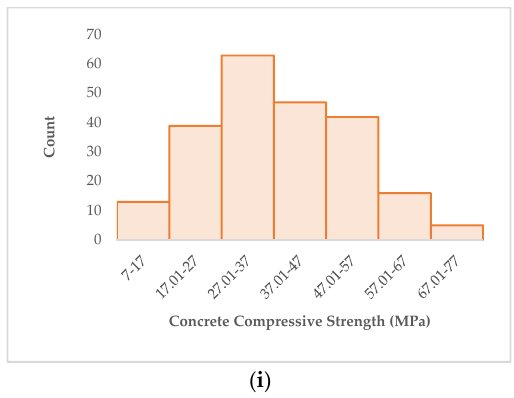
Figure 1. Frequency distribution histogram of variables. ( a ) Cement; ( b ) Blast furnace slag; ( c ) Fly ash; ( d ) Water; ( e ) Superplasticizer; ( f ) Coarse aggregate; ( g ) Fine aggregate; ( h ) Age; ( i ) Concrete compressive strength.